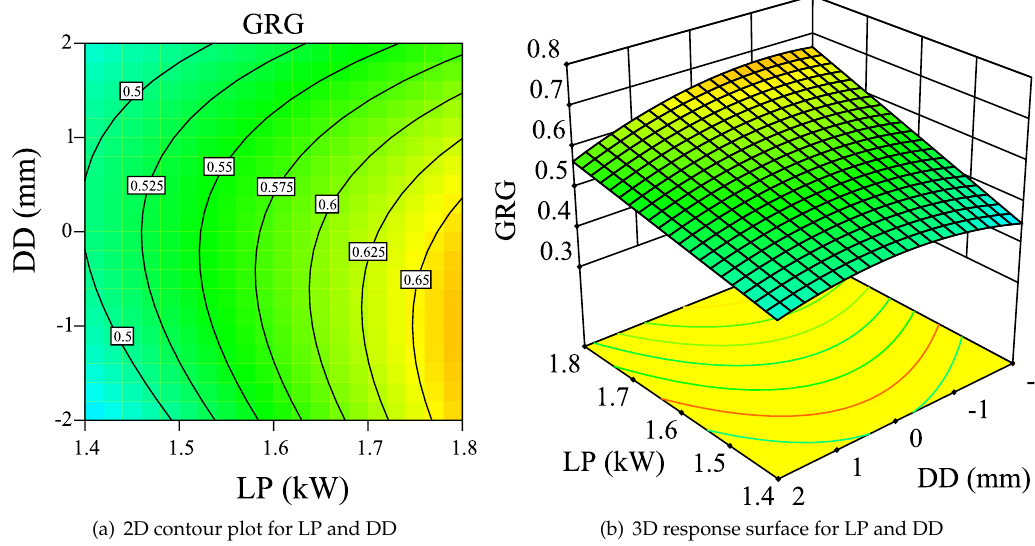
Figure 9. Response of GRG to LP and DD.